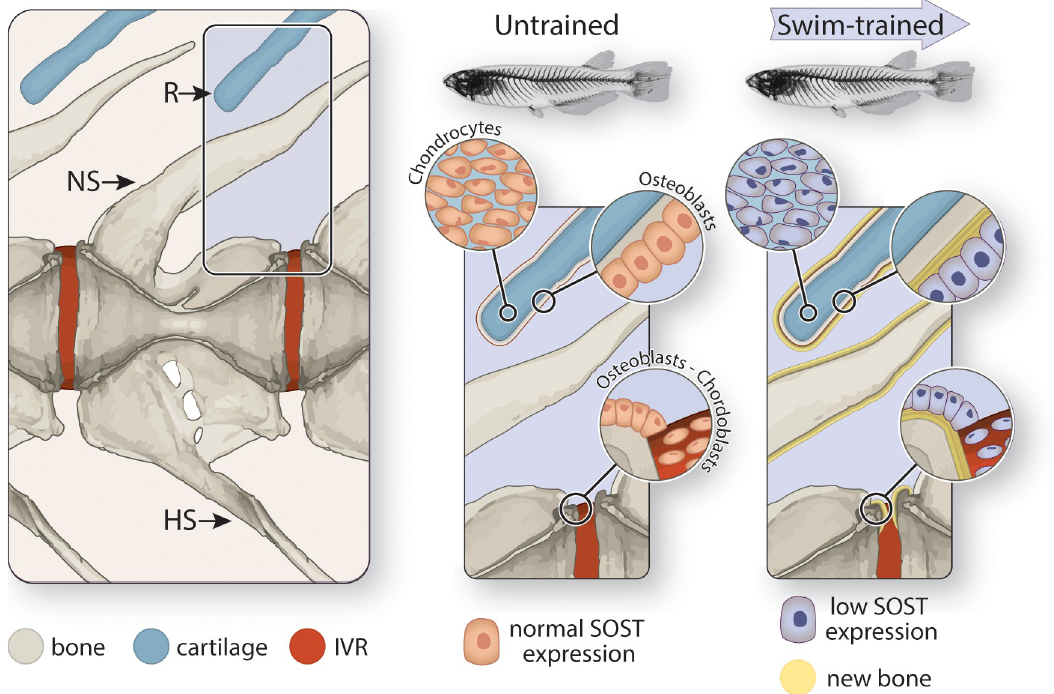
Fig 7. Schematic description of the proposed mechanism of osteocyte-independent modeling regulation in medaka vertebrae. (a) Medaka vertebra, showing the IVR, NS, HS, and R. (b) In the untrained vertebra, the chondrocytes, osteoblasts, and chordoblasts express normal levels of SOST , which maintains normal bone-deposition rate. (c) During swim training, the vertebra experiences increased strains, sensed by the osteoblasts, chondrocytes, and chordoblasts, leading to decreased SOST expression, which reduces osteoblast inhibition and results in increased bone-deposition rates. Similar, nonosteocytic SOST -mediated bone-modeling regulation was observed in the osteocytic skeletons of zebrafish, with some weak SOST expression by osteocytes as well. HS, hemal spine; IVR, intervertebral region; NS, neural spine; R,